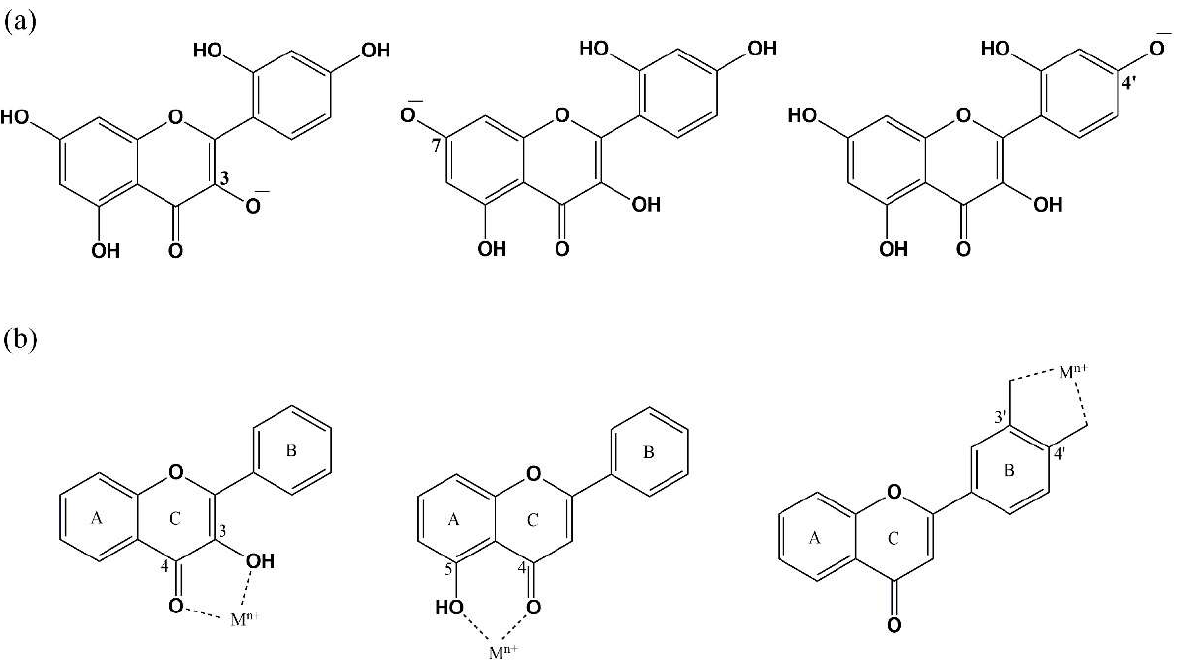
Figure 3. ( a ) The readily ionizable sites (C3, C7, and C4′) of flavonoids. ( b ) Presence of -OH or =O groups at the nearby C-atom favors the complexation process.